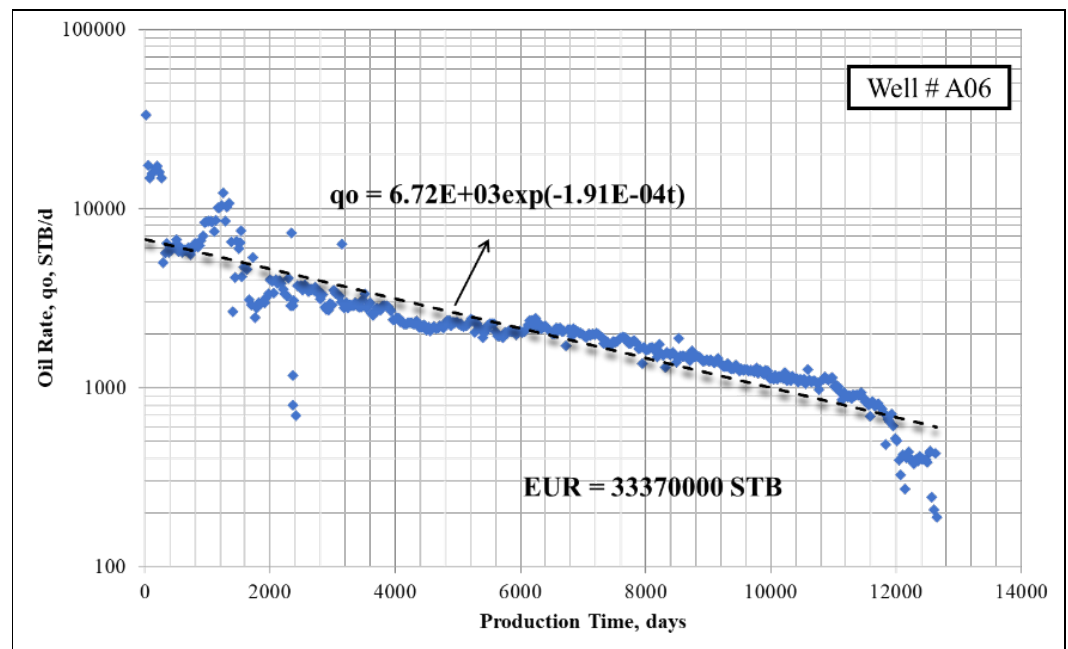
Figure 3. Oil production rate versus production time for well